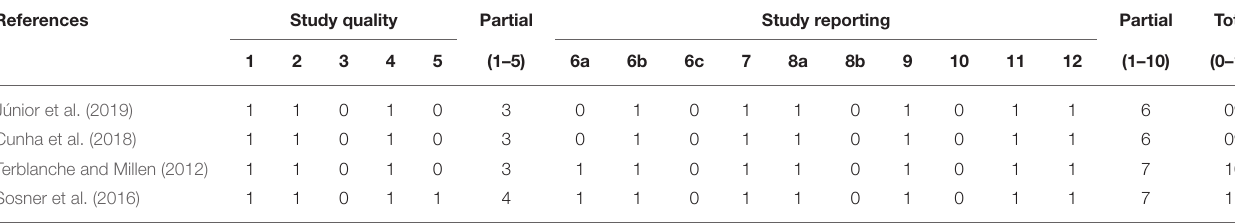
TABLE 3 | Analysis of the methodological quality of the included